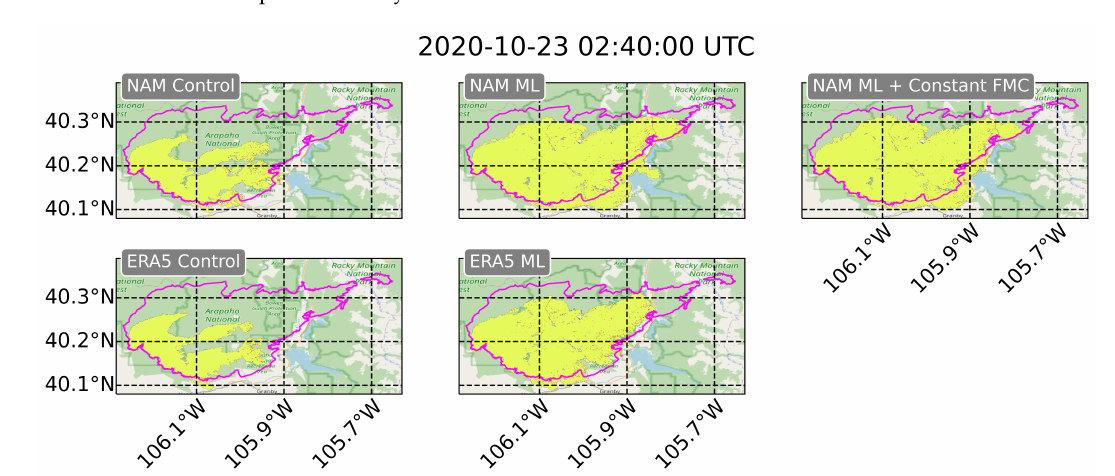
Figure 4. The sensitivity simulation results (solid yellow) using NAM meteorological data with the original fuel inputs, the modified fuel inputs, and the modified fuel inputs with a constant 8% fuel moisture content (labeled NAM Control, NAM ML, and NAM ML + Constant FMC, respectively), and the simulations using ERA5 with the original fuel inputs and the modified fuel inputs (labeled ERA5 Control and ERA5 ML, respectively). The observed fire perimeter (solid magenta line) was captured aerially at 06:40 UTC on 22 October 2020 .